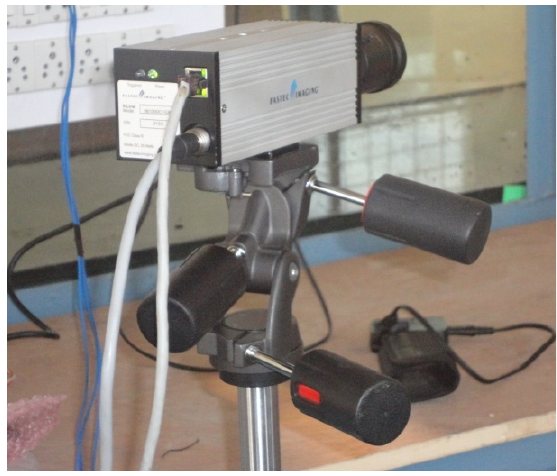
Figure 6. Fastec Imaging Inline Camera.